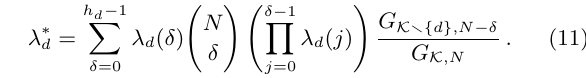
Algorithm 1: Convolution